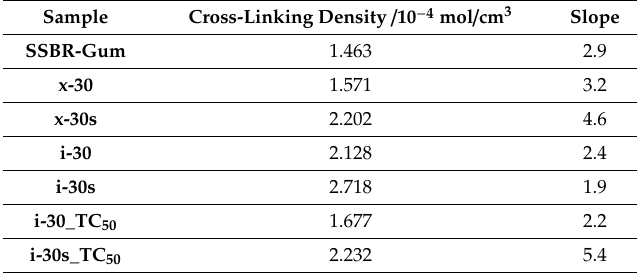
Table 2. Tear fatigue behavior of SSBR compounds filled with di ff erent silica systems with a reference to crosslinking